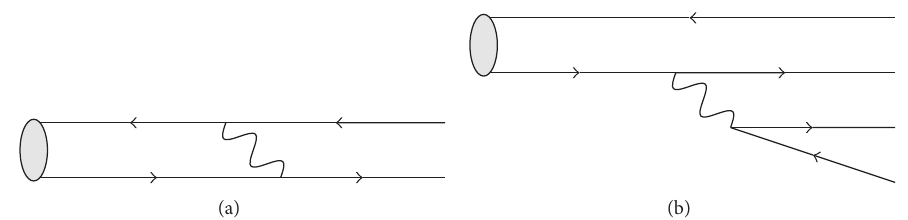
Figure 8: Weak decay modes: (a) exchange diagram with off-diagonal quark mixing element; (b) free quark decay.